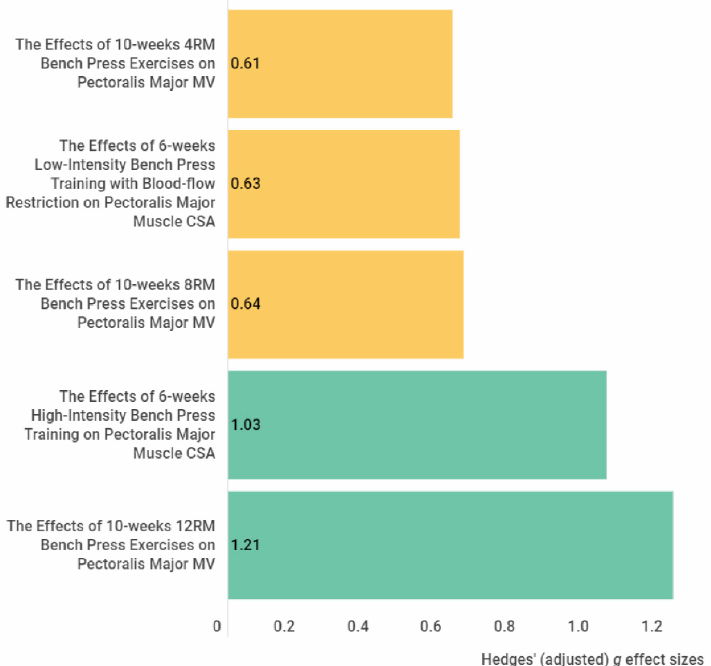
Figure 25. The effect size of the exercise interventions on the pectoralis major muscle cross-sectional area and volume. The yellow colour indicates a medium effect size, and the green colour indicates a large effect size. Abbreviations: CSA, cross-sectional area, MV, muscle volume.